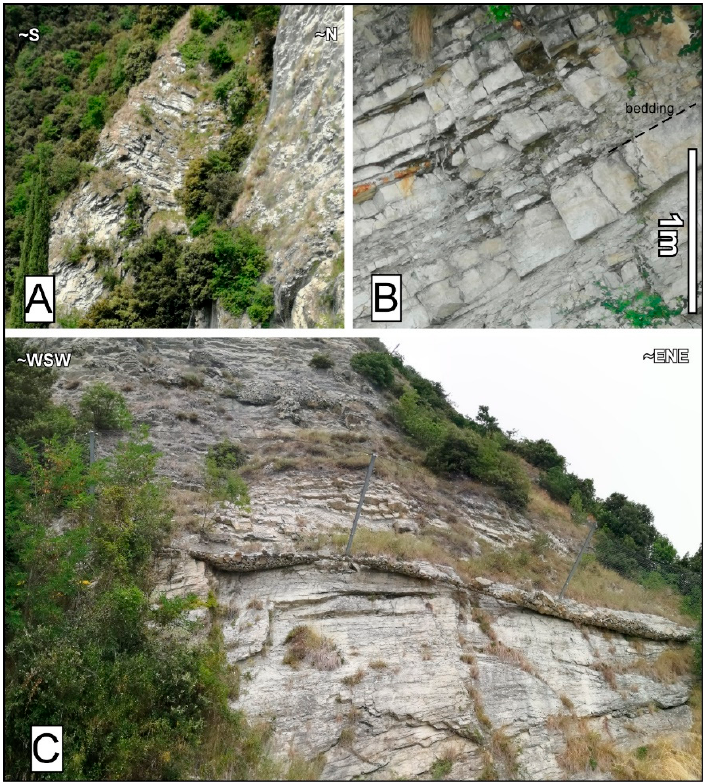
Figure 2. ( A ) Folds deforming the Jurassic succession. ( B , C ) Details of the marly-limestone multilayer in the Medolo Formation.